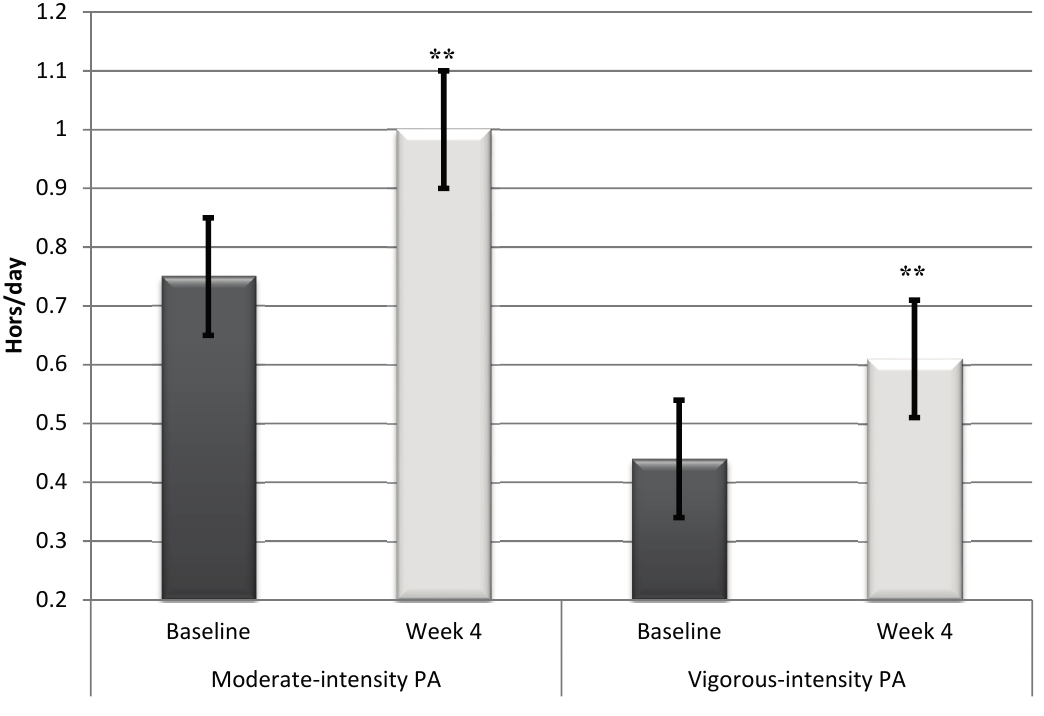
Figure 2. Increased time in both moderate and vigorous intensity physical activity from baseline to week 4 (data from Gruve monitor). ** p <